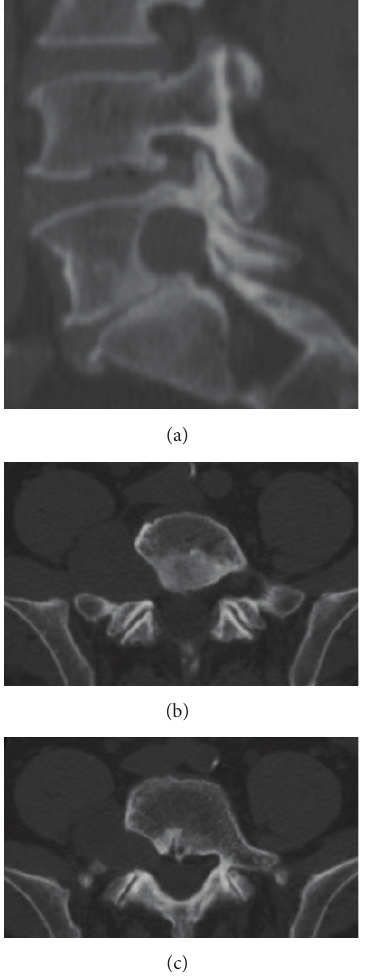
Figure 1: Preoperative spinal CT scan without contrast. The mass widened the omolateral conjugate foramen (a) and extended to the sacrum and to the ipsilateral sacroiliac joint eroding the right posterolateral portion of the L5 vertebral body (b,